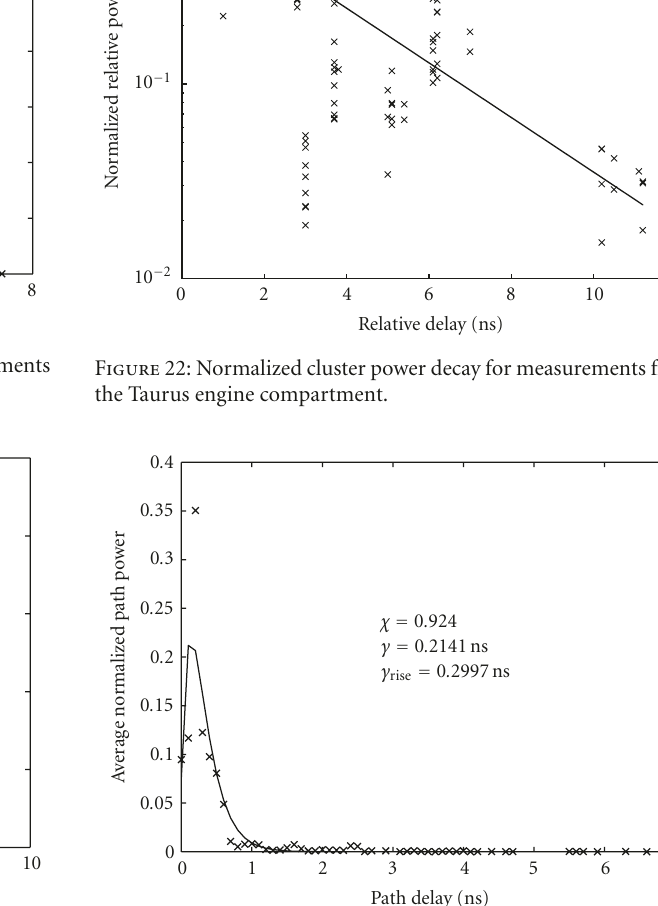
Figure 23: Average normalized path power decay for measurements beneath the Escalade chassis.